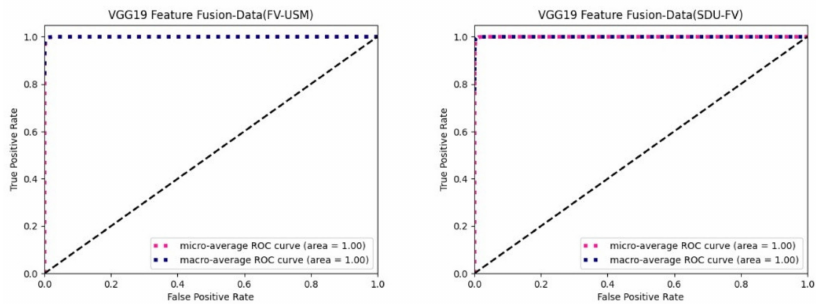
Figure 8. Fusion of identified ROC curves on the VGG-19 feature extraction network.